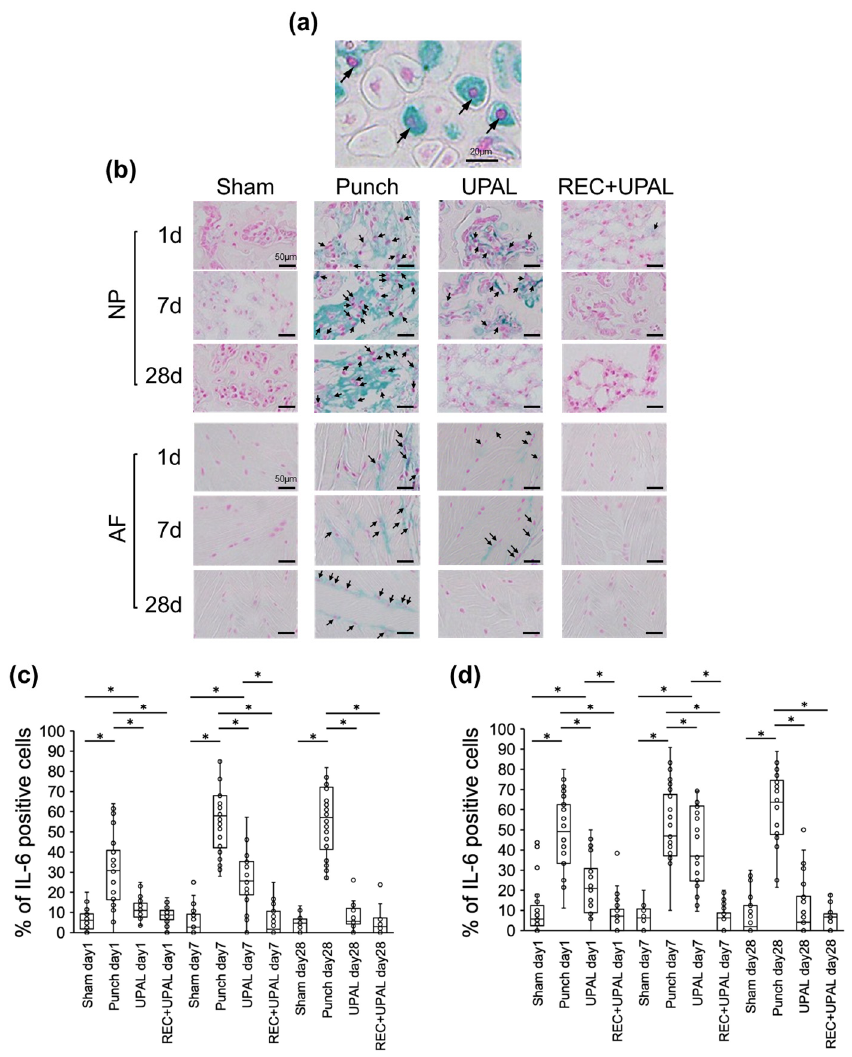
Figure 3. A mixed solution of REC and UPAL inhibits interleukin-6 (IL-6) production. Immunohis- tochemical analysis was performed on postoperative days 1, 7, and 28 to detect IL-6 levels ( a – d ). ( a ) Representative image of IL-6-positive nucleus pulposus (NP) cells (allows). IL-6-positive cells are stained in green, and nuclei are stained in red. Scale bar, 20 µ m. ( b ) Representative IHC staining for IL-6 of NP and annulus fibrosus (AF) tissues on postoperative days 1, 7, and 28. Arrows indicate IL-6-positive cells. Scale bar, 50 µ m. Percentage of IL-6-positive cells in NP tissue ( c ) and AF tissue ( d ). An asterisk (*) indicates a p -value less than 0.01. The boxes represent the median and interquartile range, while the vertical lines show the range at each time point (n = 3 rats; n = 6 IVDs in each